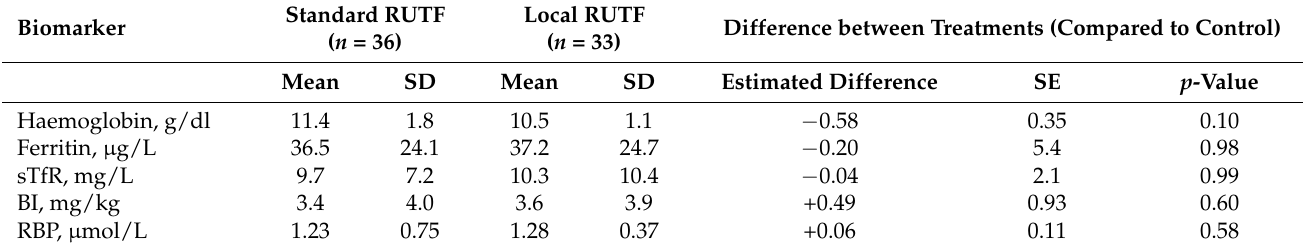
Table 6. Estimated micronutrient and inflammation status at discharge from SAM treatment per